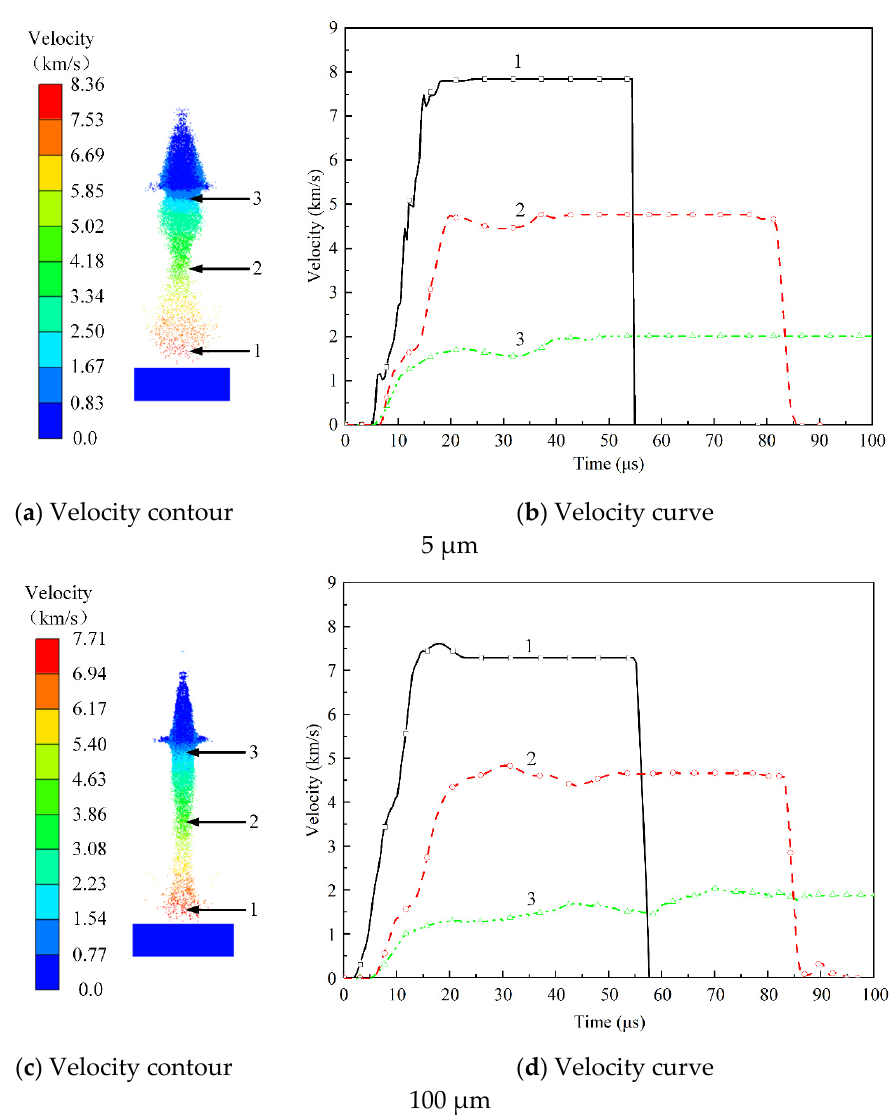
Figure 13. Velocity of shaped charge projectiles.